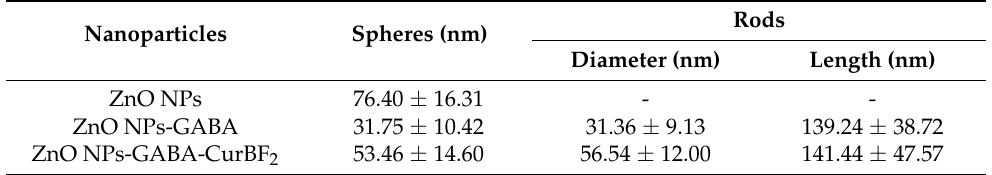
Table 1. Size of ZnO NPs, ZnO NPs-GABA, and ZnO NPs-GABA-CurBF 2 from the TEM